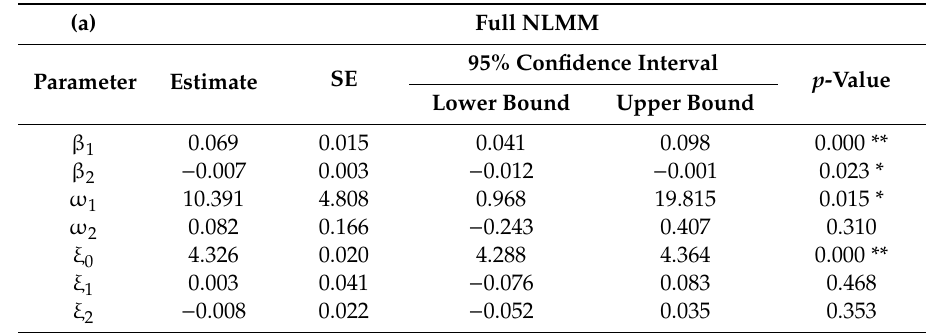
Table 1. Estimated fixed e ff ects parameters in the full non-linear mixed e ff ects model (NLMM) ( a ) and those in the optimal NLMM ( b ).